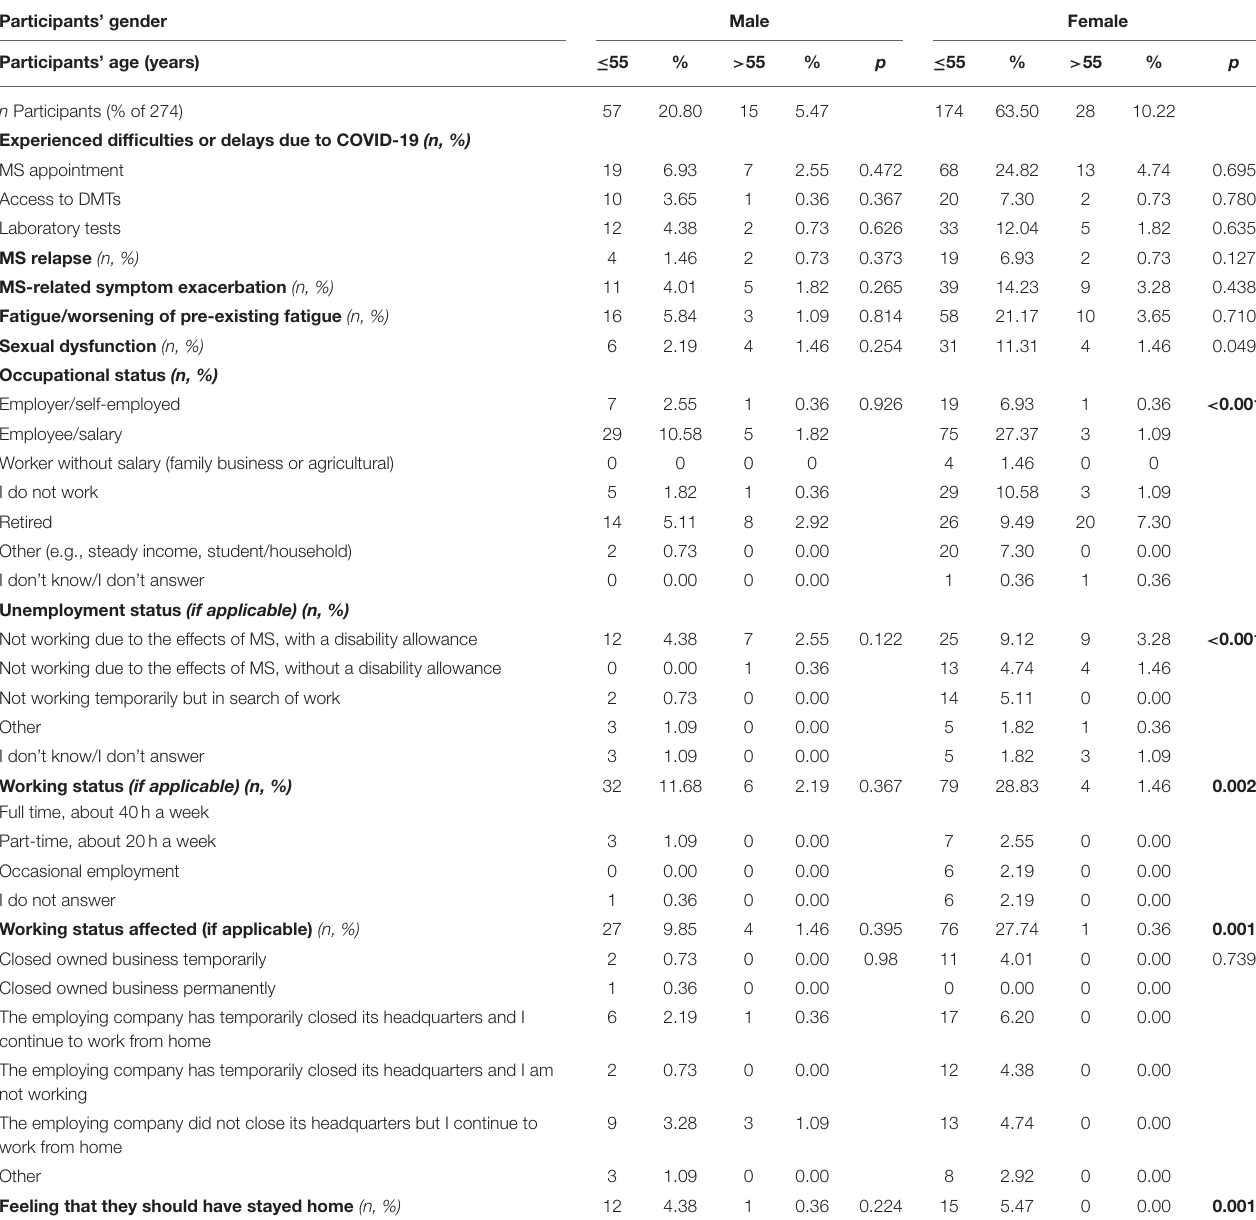
TABLE 5 | COVID-19 and multiple sclerosis care, lifestyle, and occupation in relation to multiple sclerosis, during the pandemic. Participants’